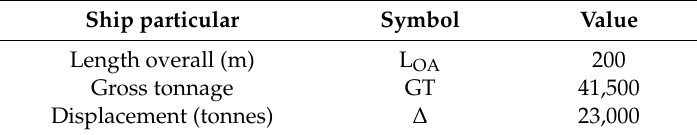
Table 2. Principal particulars of the ship used in the